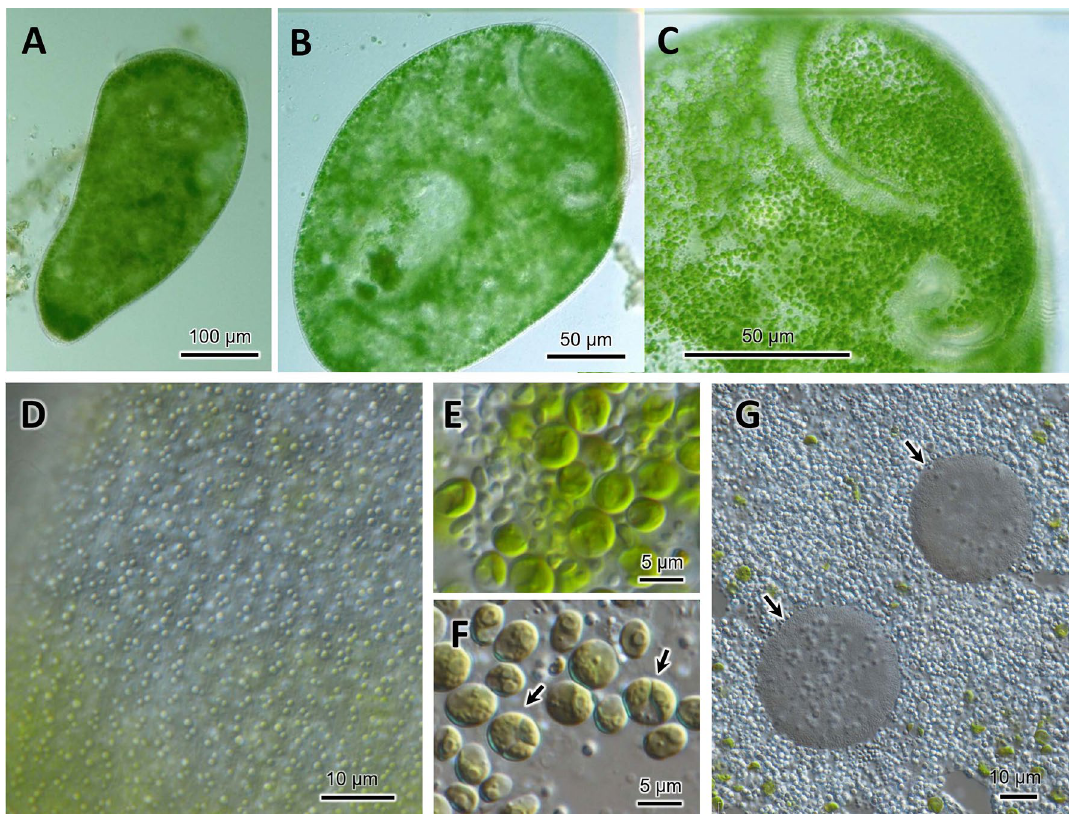
Figure 2. Light micrographs of living and crushed cells of Stentor pyriformis . ( A ). A swimming cell showing short and fat body. ( B ). A slightly squeezed cell under coverslip. ( C ). Buccal cavity. ( D ): Surface vesicles immediately under the cell surface. ( E ): Symbiotic Chlorella cells as seen in the crushed cytoplasm of S. pyriformis with starch granules. The Chlorella cells appear vividly green, and dividing cells were rarely seen. ( F ). Symbiotic Chlorella variabilis cells in Paramecium bursaria for comparison. The picture was taken under the same photographic conditions as ( E ). Cells are pale green and many dividing Chlorella cells are observed (arrows). The cell size variation was larger than that in S. pyriformis . G. Spherical macronuclei (arrows) found with abundant starch granules in the cytoplasm crushed between the slide and the coverslip.